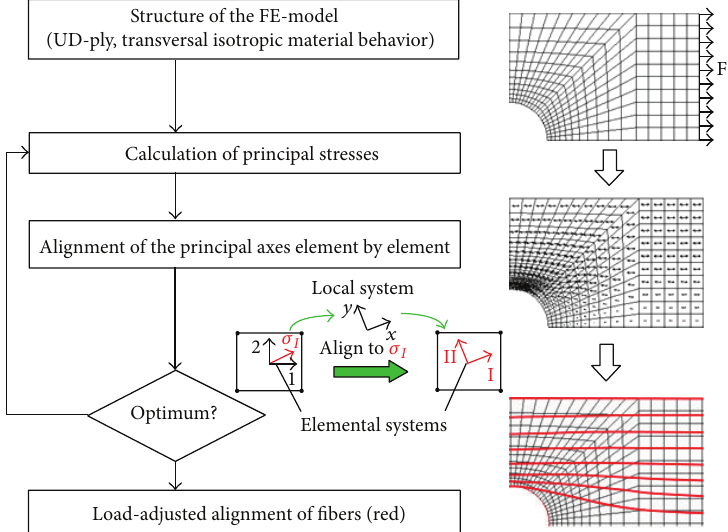
Figure 2: Determination of the optimum fiber orientation for a quarter model of a tensile-loaded UD-reinforced open-hole shell model.